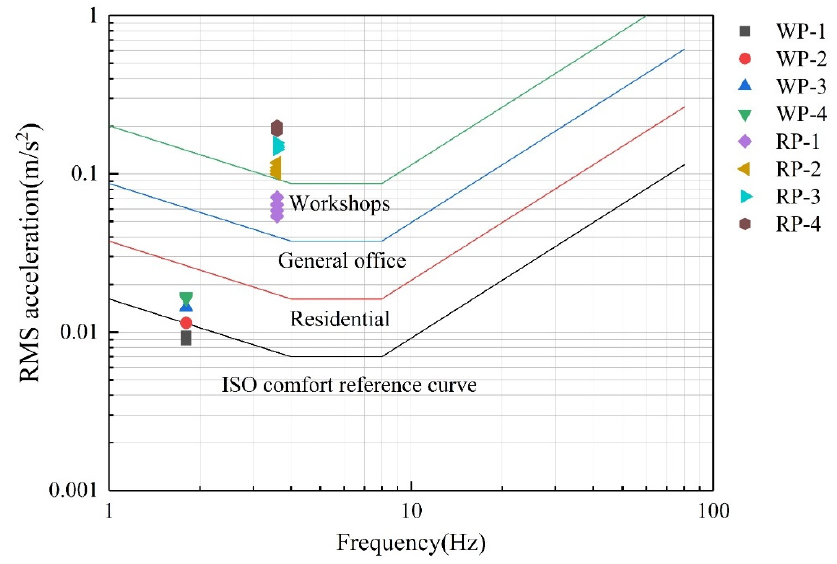
Figure 14. Vibration serviceability evaluation of the measured RMS accelerations according to ISO 10137: 2007.